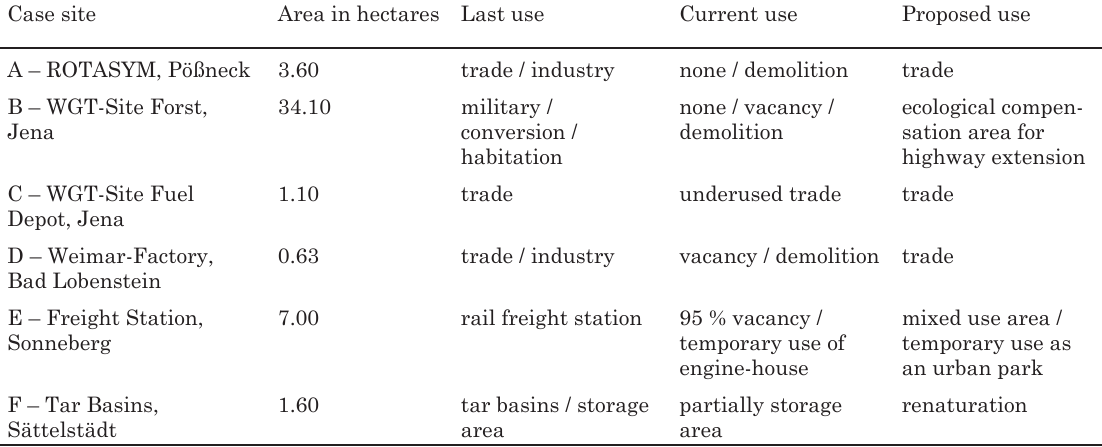
table 4. Case study sites in Thuringia,